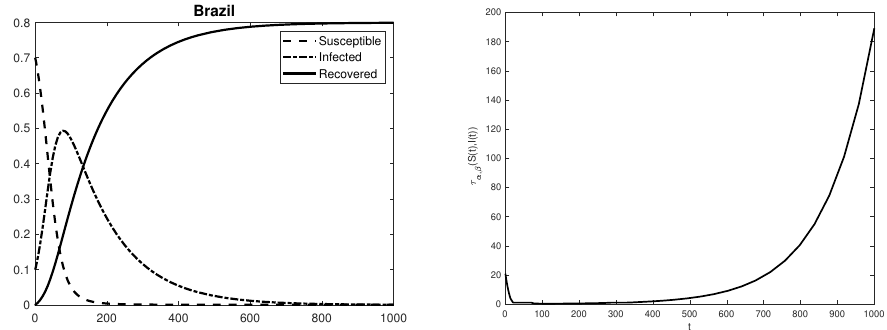
Figure 2. Solution to the SIR model (1), with initial value given by the vector (4), for Brazil ( left ) and corresponding pattern of τ α , β ( S ( t ) , I ( t )) ( right ).